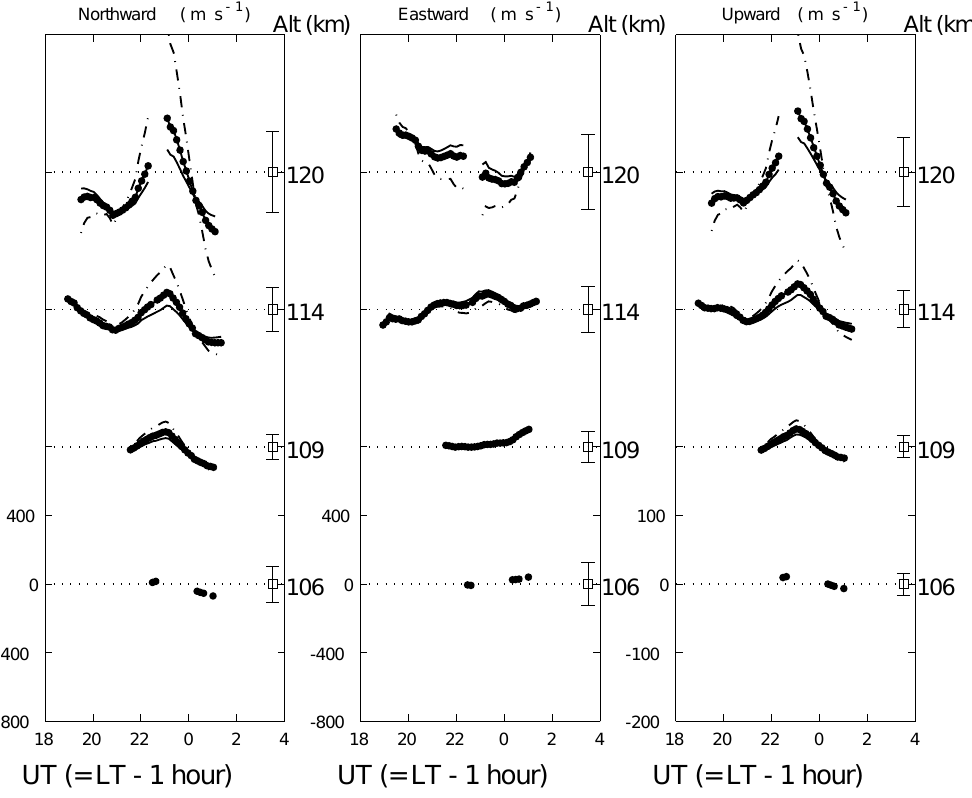
Fig. 4. Temporal variations in northward (left panel), eastward (middle panel), and upward (right panel) components of the neutral-wind velocity calculated with three kinds of neutral density data; original MSIS-model value (solid curve with dots), and 50% increase (solid curve) and decrease (dash-dotted curve) at 120km height from the original MSIS-model value (see text for details). The vertical bar at each height is the mean error value ± 1 σ for this time